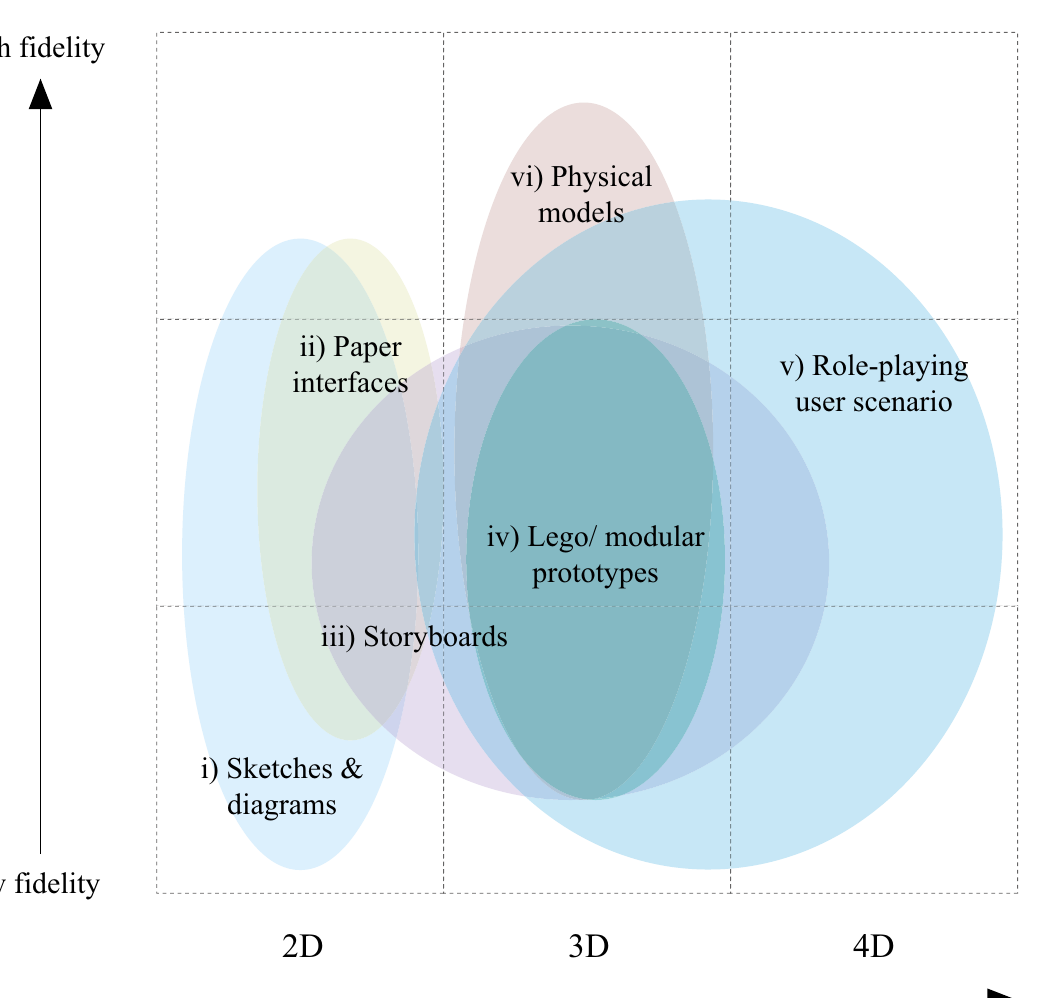
Figure 1: A matrix of prototyping methods illustrates two significant spectra of a prototype’s characteristics. Designers may quickly visualise the most appropriate method according to current resources on hand during the prototype planning process. The paths of red arrows illustrate the designer’s identification of the most reasonable type of prototype across different characteristics as shown in the two dimensions. Source: